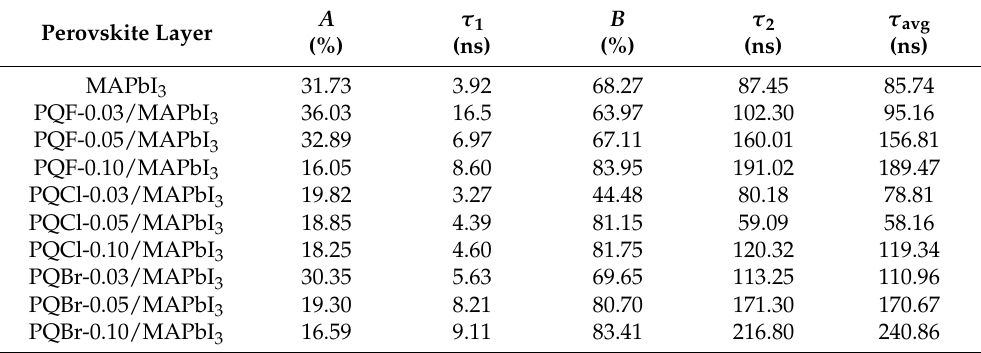
Table 2. Fitted parameters of the TRPL spectra of MAPbI 3 films coated on cellulose derivative– modified NiO x layers coated on FTO glass.